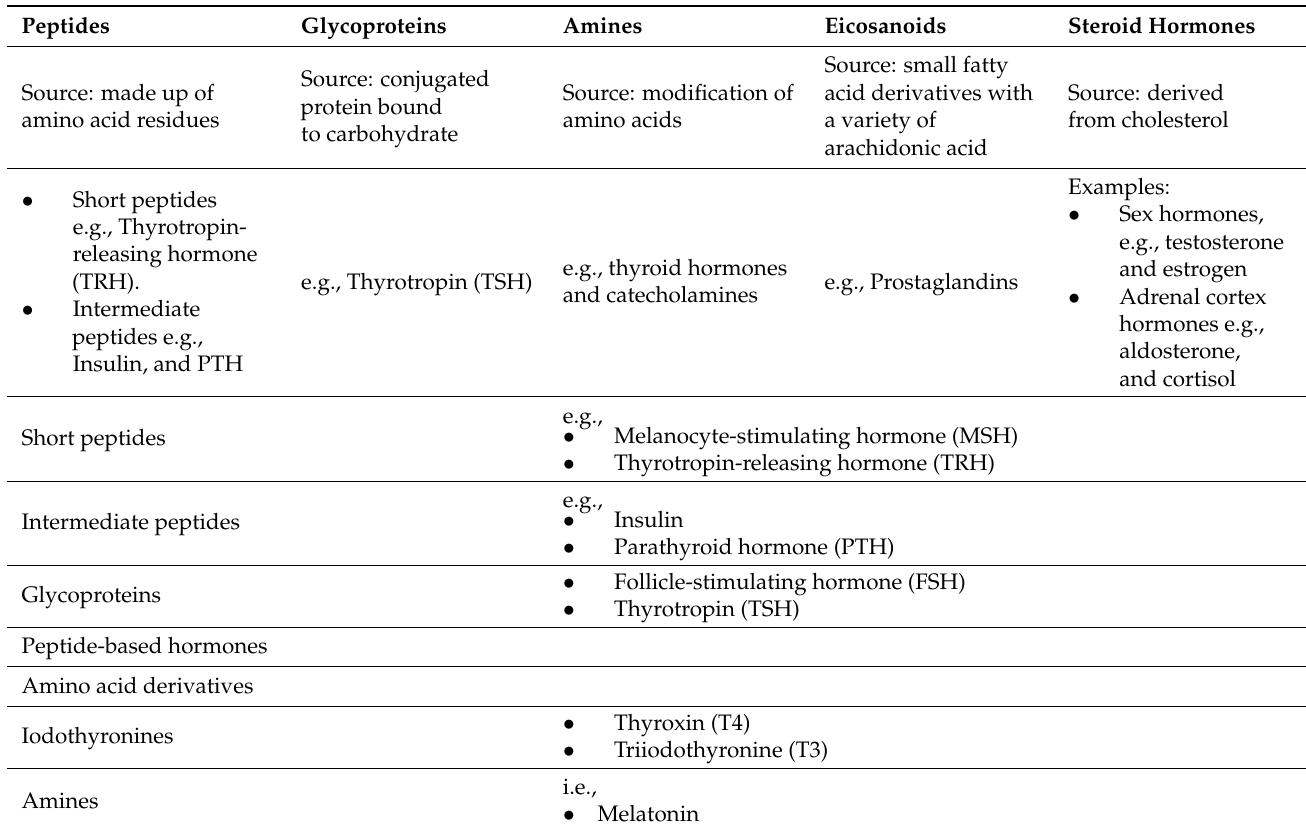
Figure 4. Mechanisms of hormonal actions. Table 3. Classification of